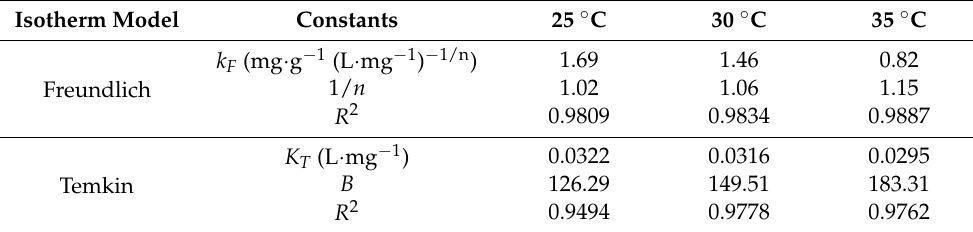
Table 5. Constants of two isotherm models for Cu 2+ adsorption by the rGO membrane. Isotherm